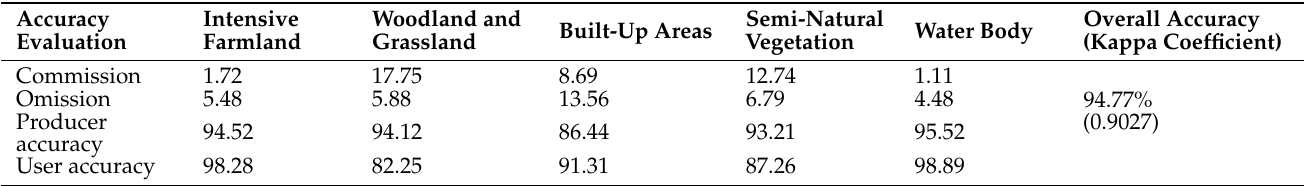
Table 2. Accuracy evaluation of each land cover type in SVM model.